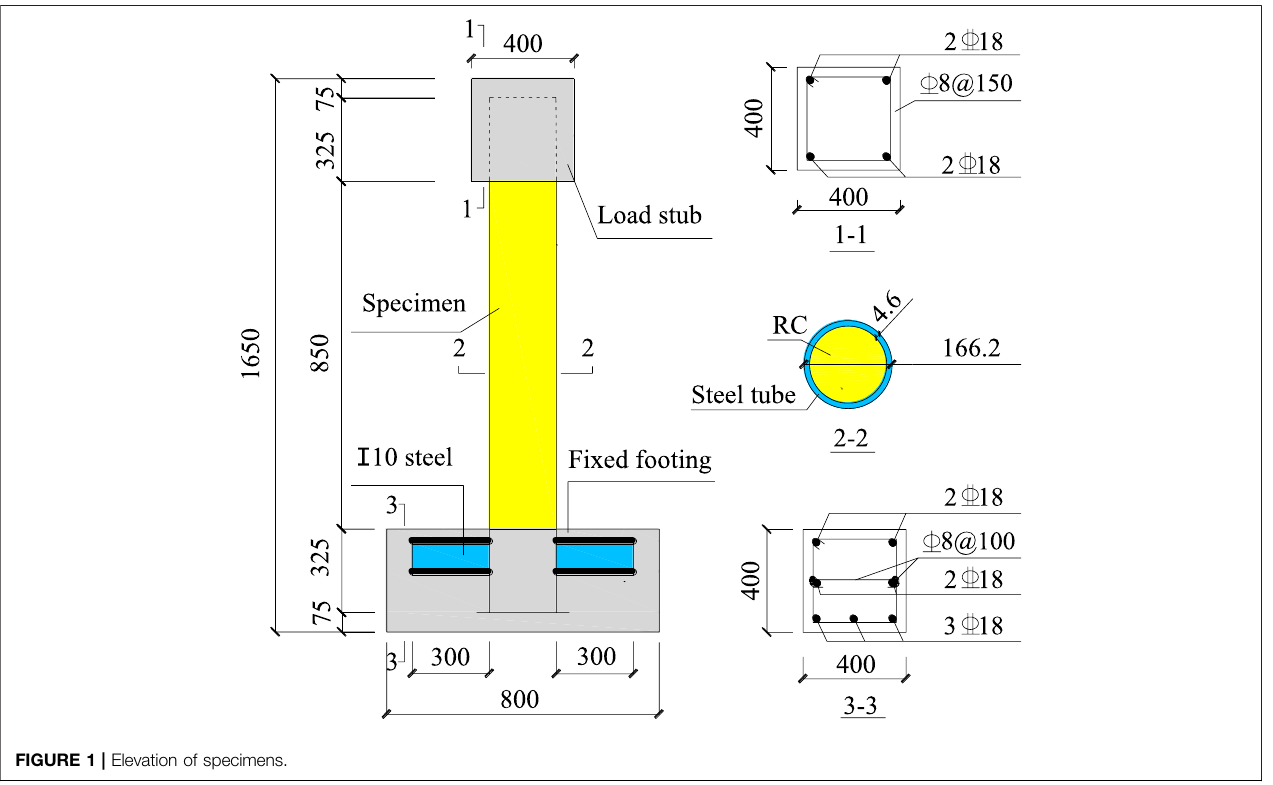
FIGURE 1 | Elevation of specimens.